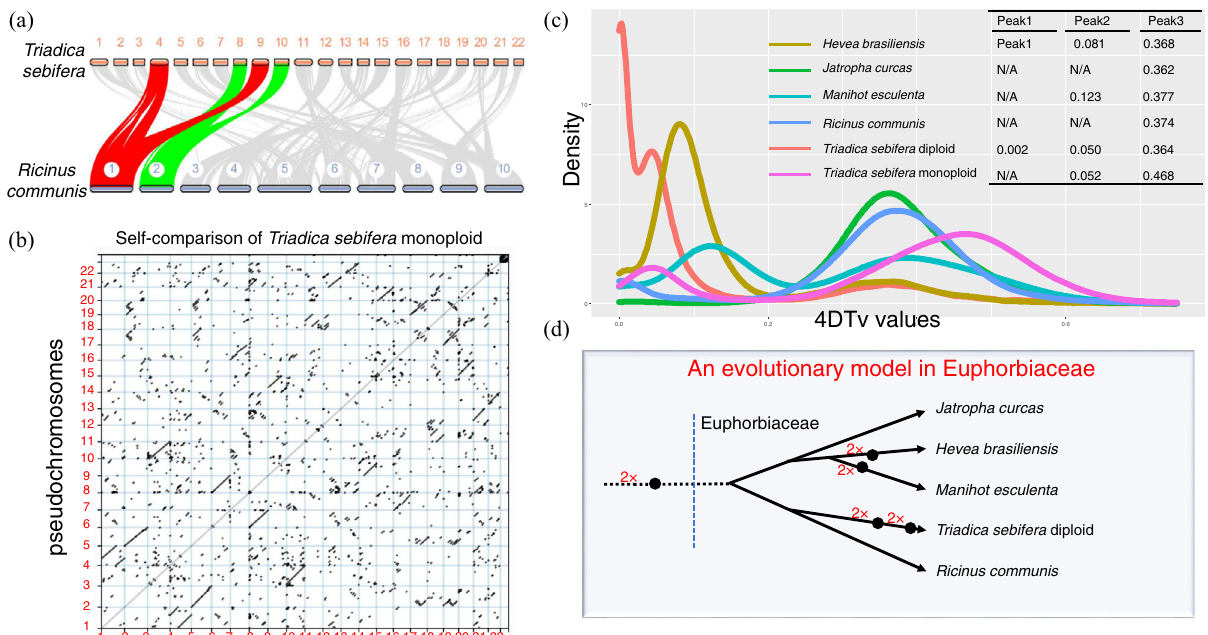
Fig. 3 Genome duplication analysis for the Chinese tallow tree (CTT). a Synteny comparison of the CTT monoploid genome with Ricinus communis genome. Bars indicate chromosomes or scaffolds, while lines indicate synteny blocks between the two genomes. Synteny blocks for chromosomes 1 and 2 in the R. communis genome are highlighted with red lines, which indicates that one locus matches two counterparts in the CTT genome. b Self-comparison of the CTT monoploid genome. Both the x- and y- axes indicate the scaffold of the CTT monoploid genome. c Frequency plot of the fourfold synonymous (degenerative) third-codon transversion (4DTv) values for six genomes, namely, Hevea brasiliensis , Jatropha curcas , Manihot esculenta , Ricinus communis , CTT diploid, and CTT monoploid. d An evolutionary model predicted for some plants in the Euphorbiaceae family. A black dot indicates that a whole genome duplication occurred. The line length roughly indicates divergent